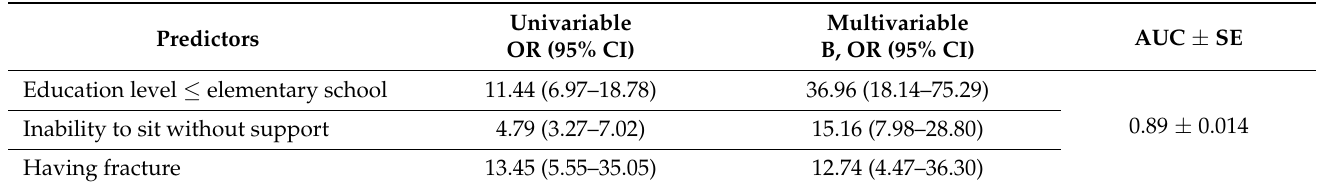
Table 4. The univariable and multivariable logistic regression results of modified physical disability components in derivation group.